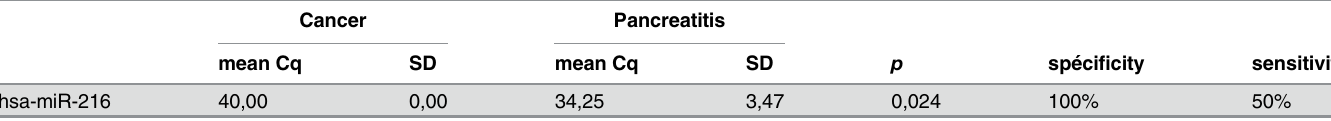
Table 3. Average Cq values, sensitivity and specificity of the candidate